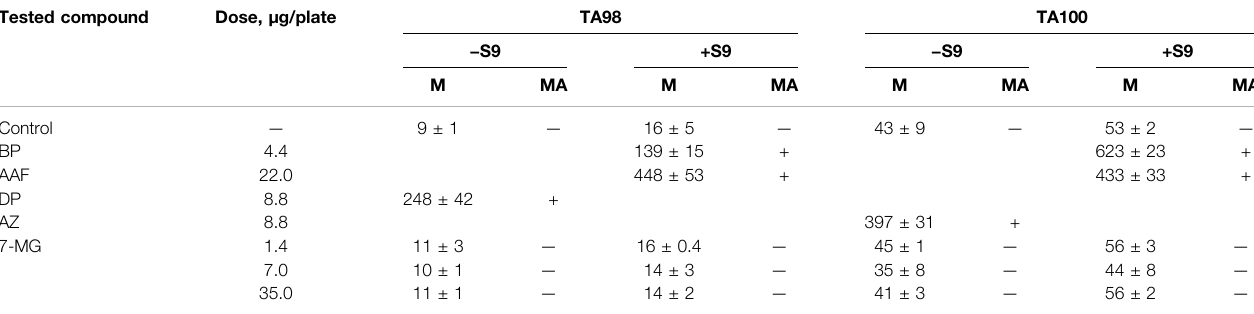
TABLE 2 | Study of the mutagenicity of 7-MG in S. typhimurium strains TA98 (detects frameshift mutagens) and TA100 (detects mutagens that cause base-pair substitutions). Tested compound